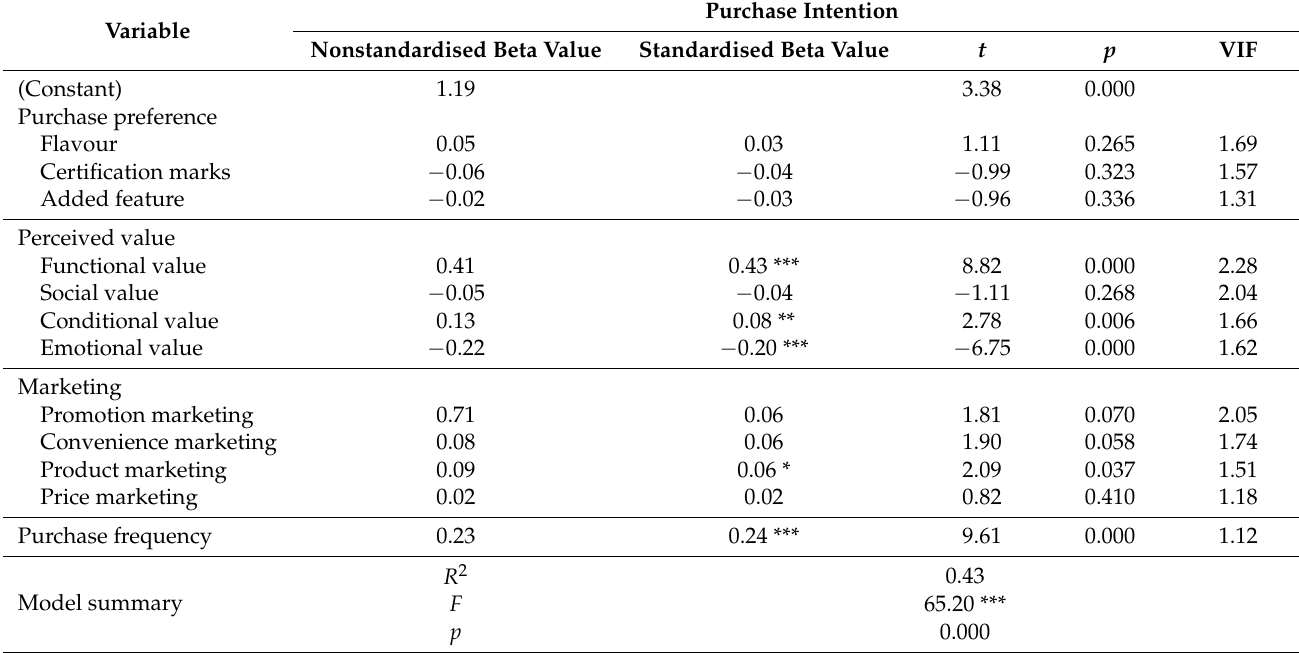
Table 3. Regression analysis of purchase intention ( n = 1042).